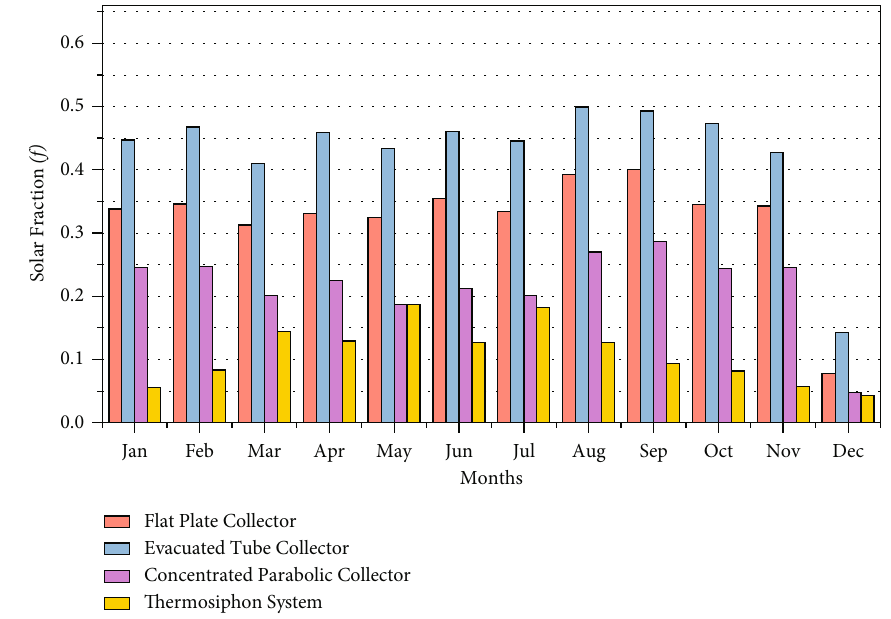
Figure 11: Comparative graph of solar fraction for various collectors.